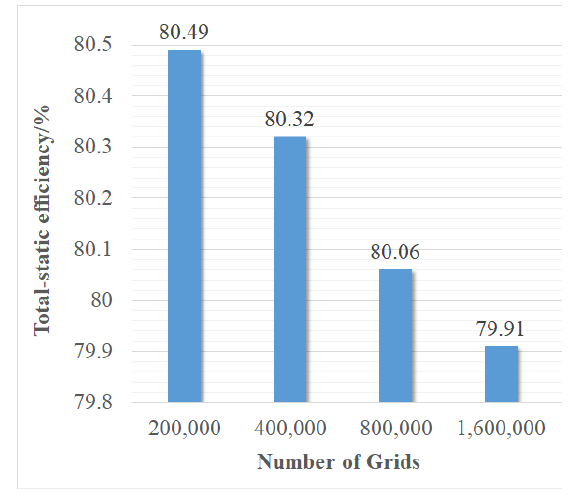
Figure 8. The grid independence.